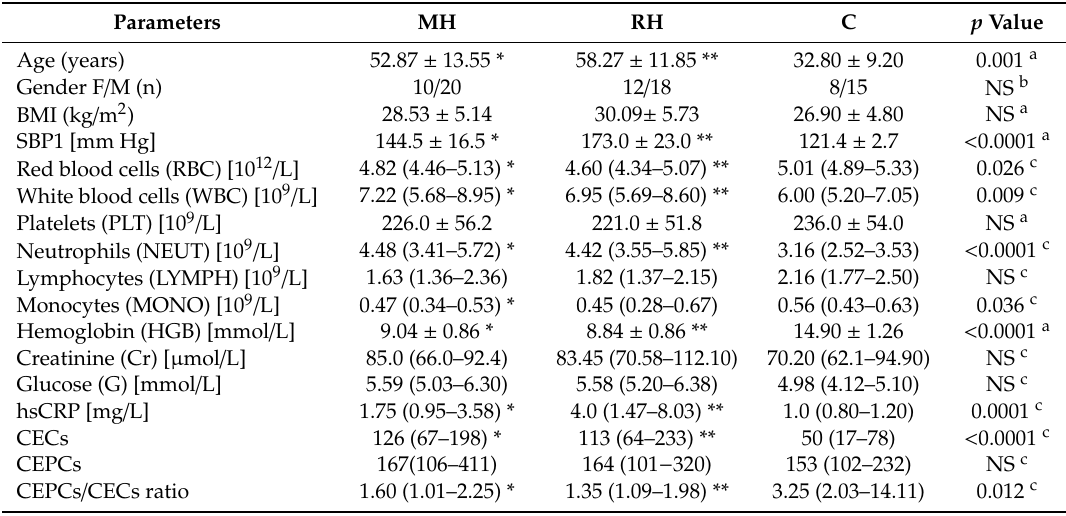
Table 7. Demographic characteristics and biochemical parameters in the plasma of MH, RH